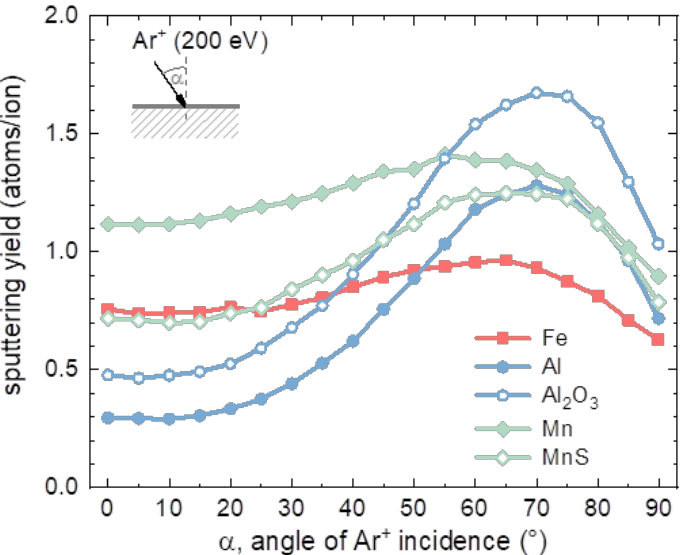
Figure 11. Sputtering yields as a function of Ar + incidence angle for several substrate materials investigated in this work. Calculations were performed by SRIM program.